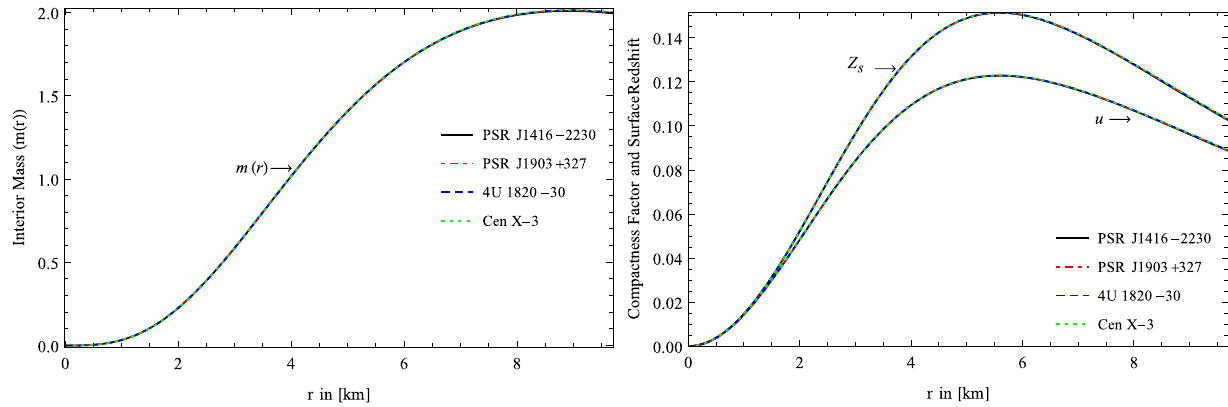
Fig. 5 The variation of mass function (left panel) and compactness parameter and surface red-shift (right panel) with the radial coordi- nate r for experimental statistics of four different compact stars. For